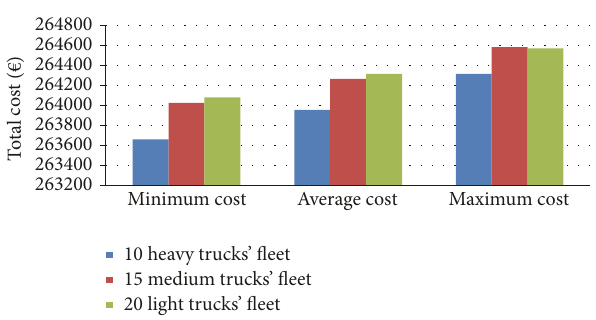
Figure 6: Minimum, average, and maximum cost for the three vehicle